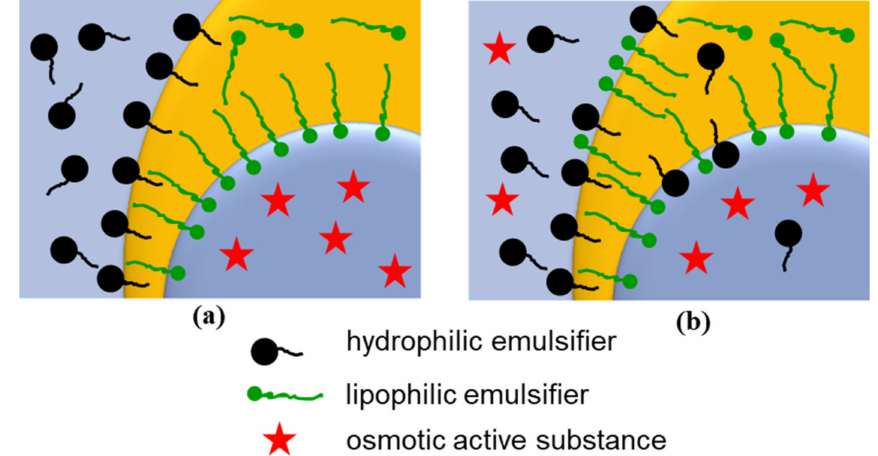
Figure 1. Schematic drawing of the composition of the interfaces in double emulsions. ( a ) Idealized distribution: each emulsifier only adsorbs at the interface it prefers, and the osmotic active substance is dissolved in the inner water phase. ( b ) Realistic distribution: the emulsifiers will distribute between all phases and interfaces and interact with each other at the interfaces; the osmotic active substance is found in both water